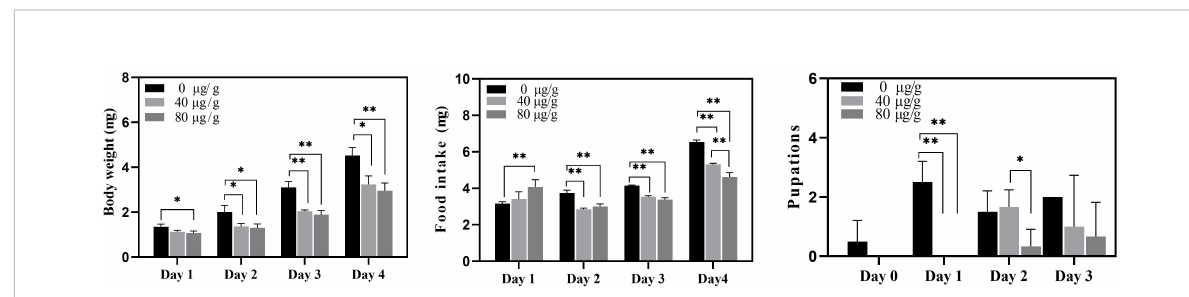
FIGURE 2 Bioassays of puri fi ed recombinant Cry7Ab4 toxic core. P. xylostella larvae (fourth-instar day 2) were fed diets containing 0, 40, and 80 µg/g of puri fi ed recombinant Cry7Ab4 toxic core; the average weight of larvae (A) , amount of diet intake (B) , and pupation time (C) were recorded after feeding Cry7Ab4 toxin. Signi fi cant difference was determined by Student ’ s t-test between two groups, indicated by *( p < 0.05), **( p <